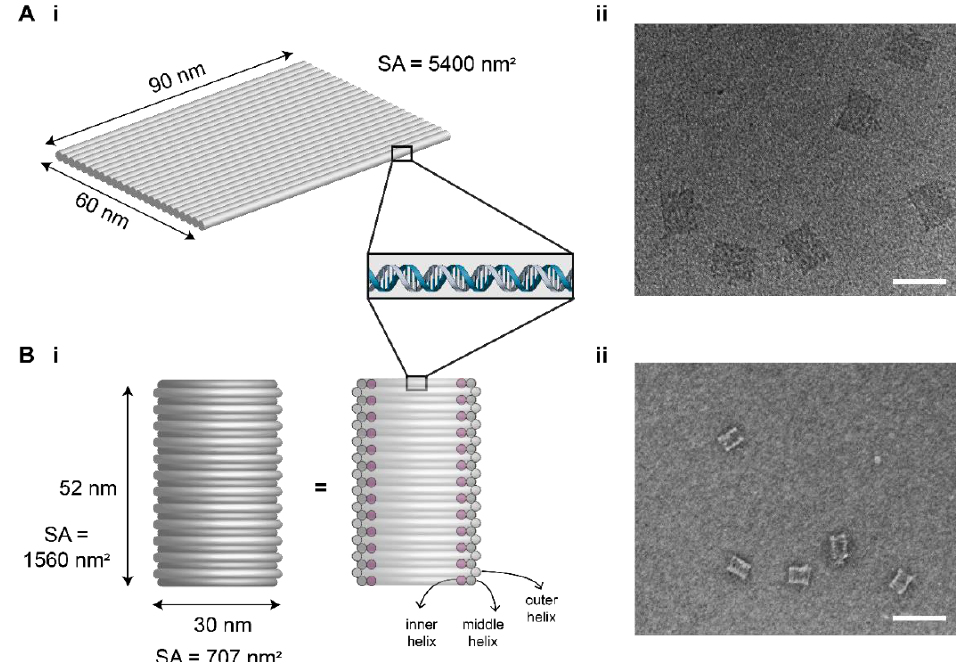
Figure 1. Design of DNA origami nanostructures used in this study. ( A ) DNA origami tile (DOT); ( B ) DNA origami barrel (DOB). ( i ) Schematic of the nanostructures. ( ii ) TEM images of nanostructures. Scale bar: 100 nm. SA = surface area.